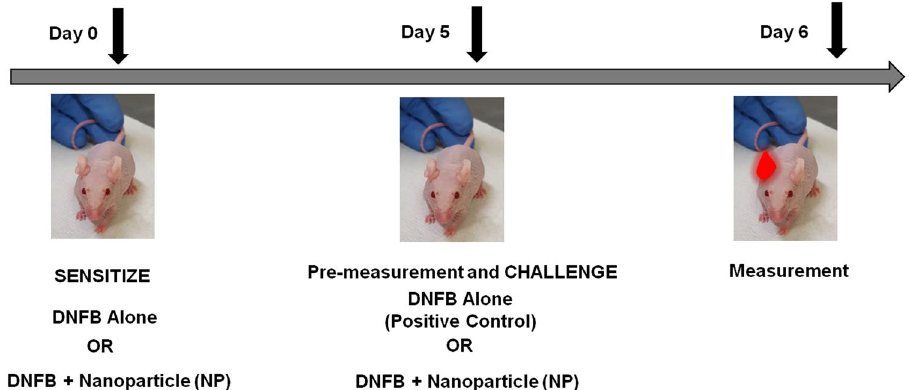
Figure 1. Protocol for testing the effect of NPs on the sensitization and challenge phases in the contact hypersensitivity (CHS) mouse model using C57BL/6 hairless mice. The mice were sensitized on day 0 with 1) 0.05% DNFB alone, 2) 0.05% DNFB with negatively charged GSH coated QD, or 3) 0.05% DNFB with positively charged PEI coated QD, in acetone/olive oil medium on the dorsal back. On day 5 both the right and left ears were pre-measured before the challenge. The ears were challenged with 1) 0.2% DNFB alone, 2) 0.2% DNFB along with combinations of differently charged QD (QSH-QD negative charge, PEI-QD are positive charge, mPEG-QD neutral and lipophilic QD), or 0.2% DNFB along with combinations of other NPs that are commercially available (silica NP, gold NP, Ag NP, carbon nanotubes and titanium dioxide). On day 6, 24